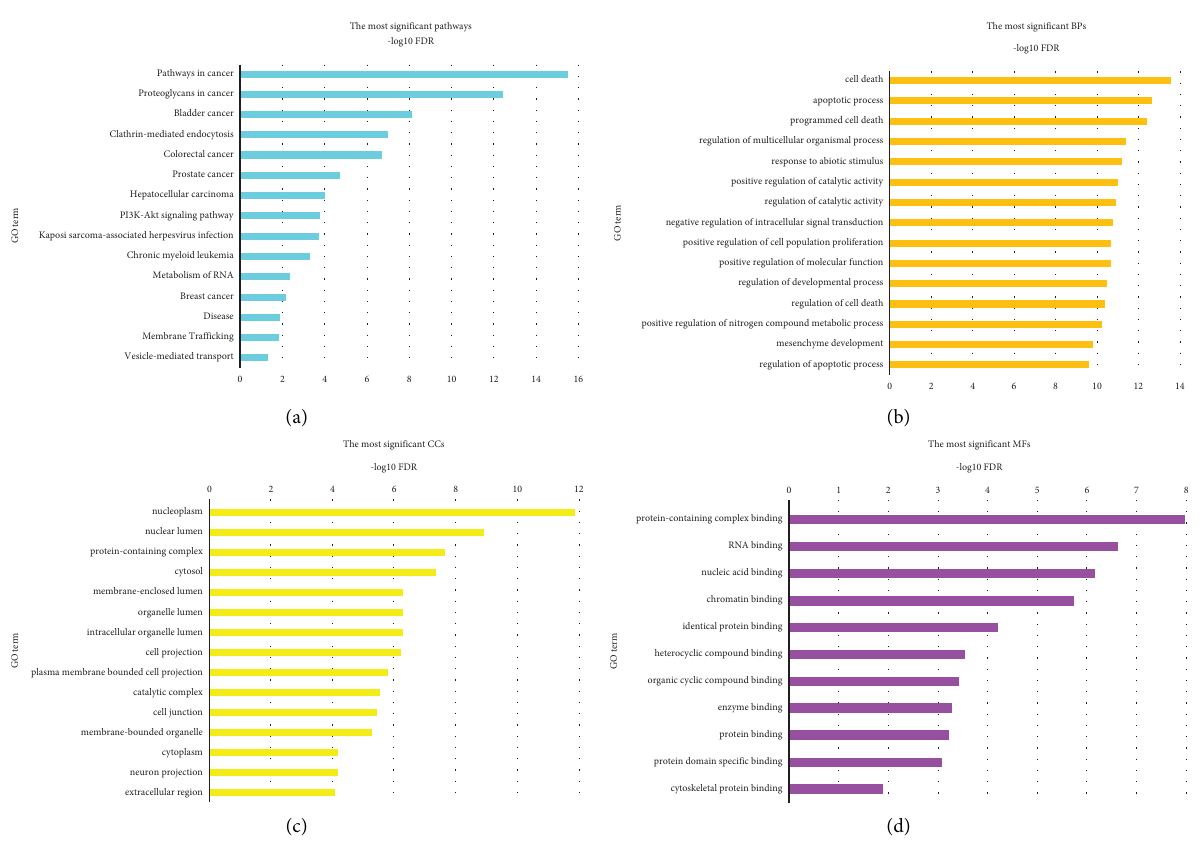
Figure 3: Te most signifcant (a) pathways, (b) biological processes, (c) cellular components, and (d) molecular functions dysregulated in OTSCC and BSCC. Te x -axis shows the pathway and GO term’s names, while the y -axis demonstrates − Log10 of the false discovery rate. OTSCC, oral tongue squamous cell carcinoma; BSCC, buccal squamous cell carcinoma; GO, Gene